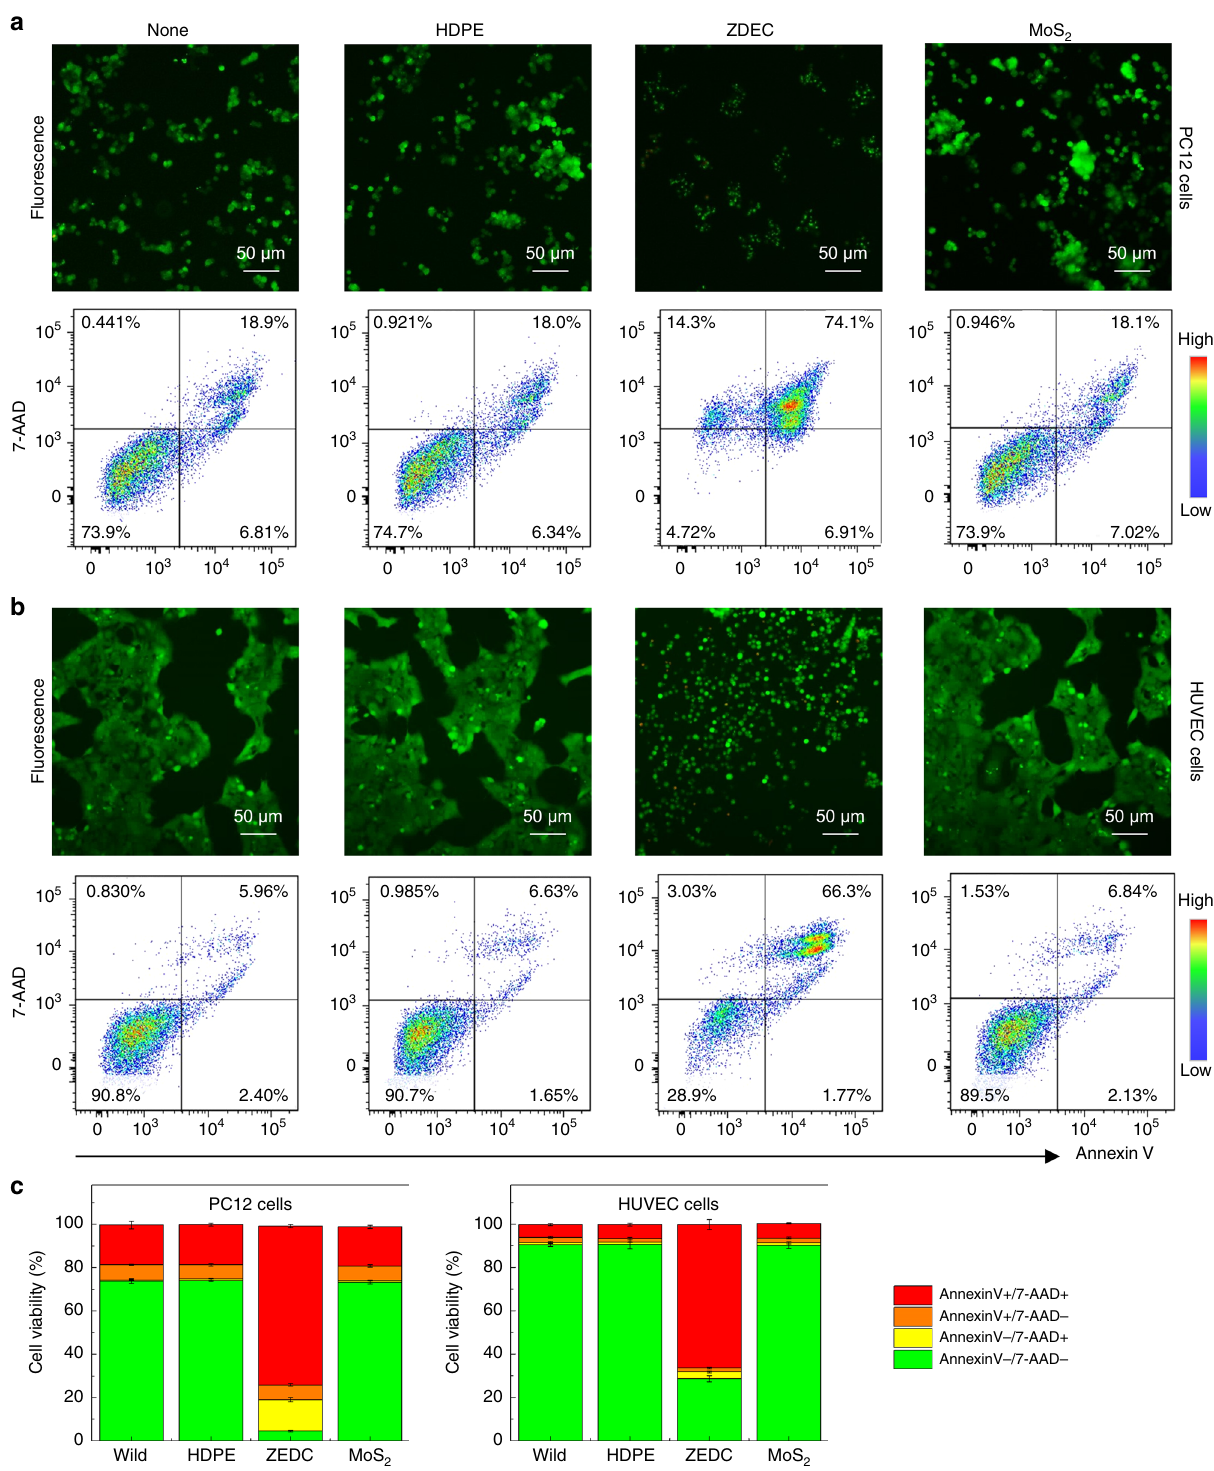
Fig. 3 In vitro biocompatibility tests of the polycrystalline MoS 2 monolayer. a , b Fluorescence images (top) and apoptotic/necrotic cell death pro fi les analyzed by fl ow cytometry (bottom) of PC12 pheochromocytoma neuronal origin cells ( a ) and HUVEC endothelial cells ( b ) upon 24 h culture with none, HDPE, ZDEC, and MoS 2 continuous fi lms. c Cell viability assessed as AnnexinV − /7-AAD − live, AnnexinV + /7-AAD − early apoptotic, AnnexinV + /7- AAD + late apoptotic, and AnnexinV − /7-AAD + necrotic cell populations in each condition is averaged and plotted as bar graphs with standard